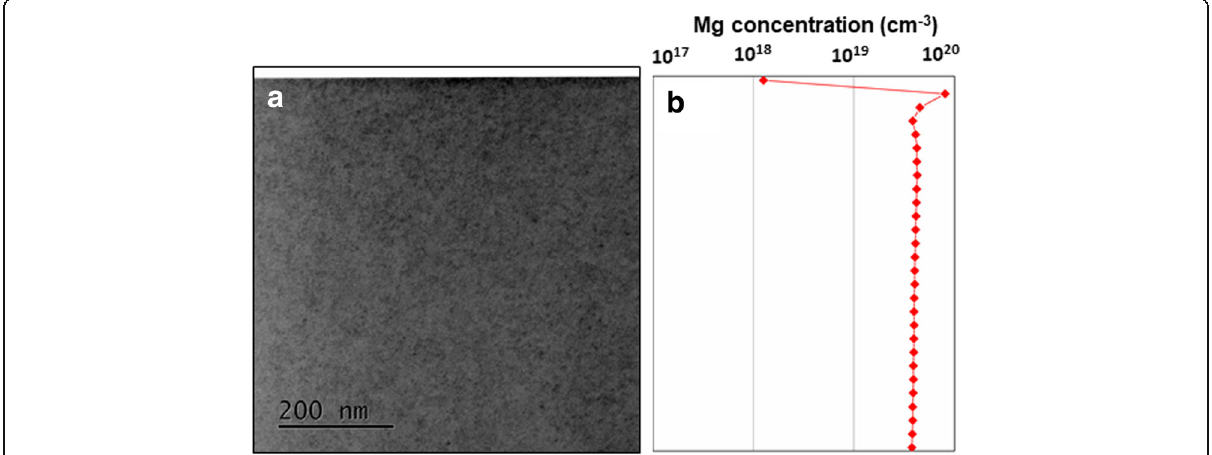
Fig. 5 a Cross sectional bright field STEM image of Mg-doped bulk GaN sample obtained along [112 ̅ 0] axis and b corresponding depth profile of Mg obtained using SIMS. Dot-like defects are found to be uniformly distributed across the sample